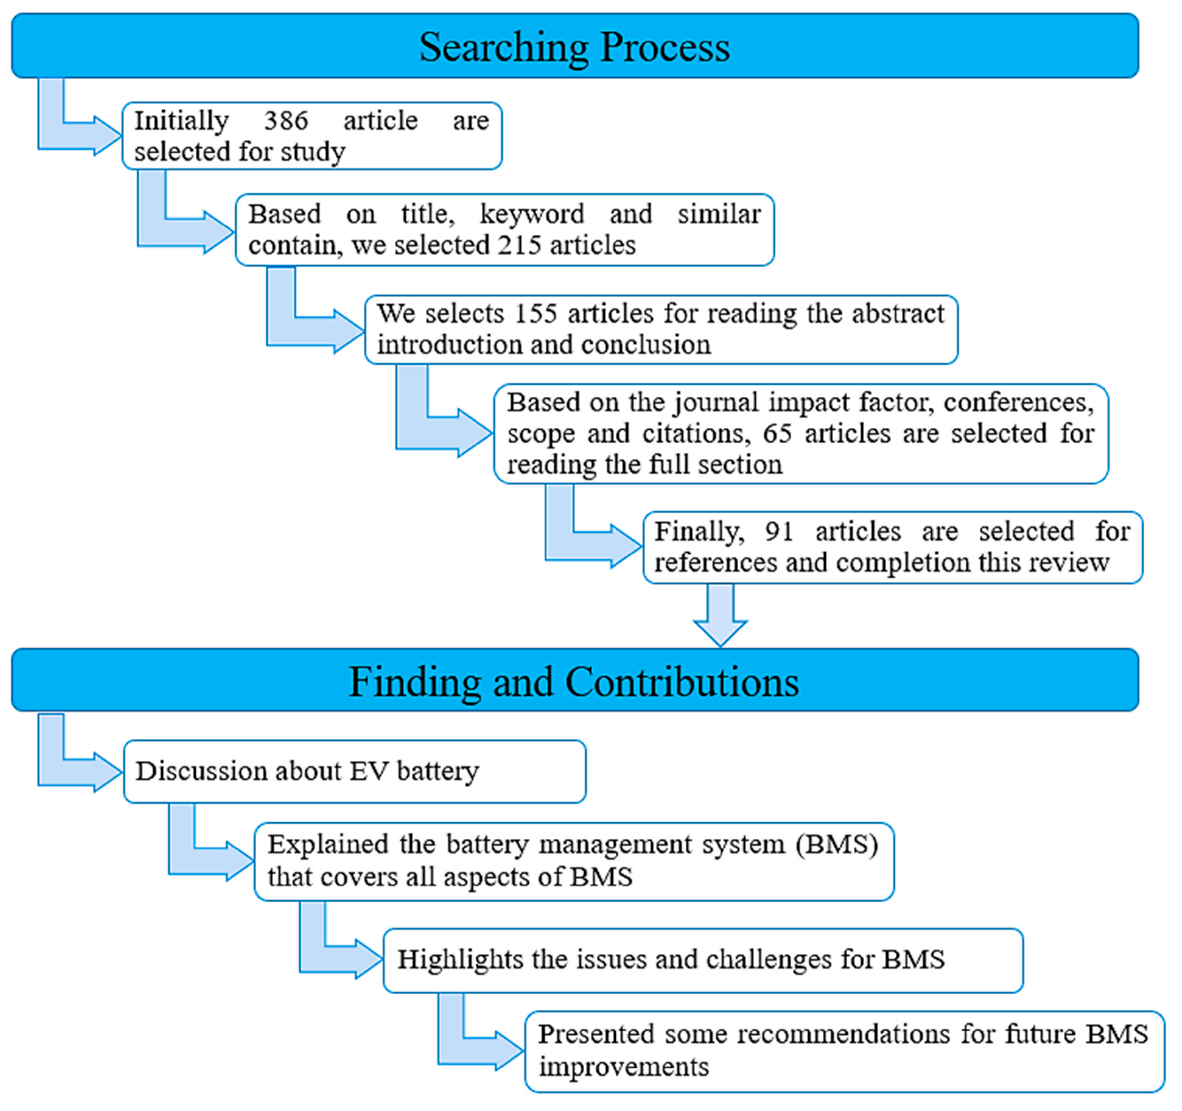
Figure 4. Schematic design of the reviewing methodology.